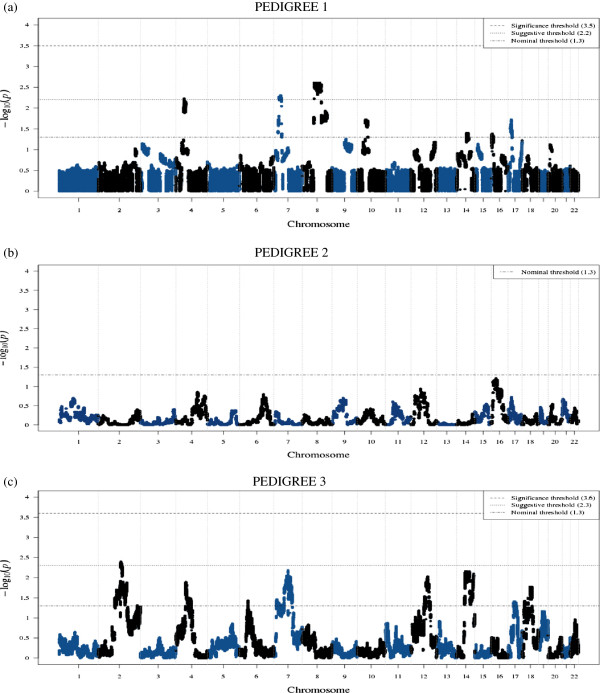
Genomewide pSGS results. For pedigree 1, genomewide suggestive and significance pSGS thresholds were estimated to be p=6.5×10-3 (−log10p=2.2) and p=3.0×10-4 (−log10p=3.5), respectively. For pedigree 3, genomewide suggestive and significance pSGS thresholds were estimated to be p=5.0×10-3 (−log10p=2.3) and p=2.5×10-4 (−log10p=3.6), respectively.